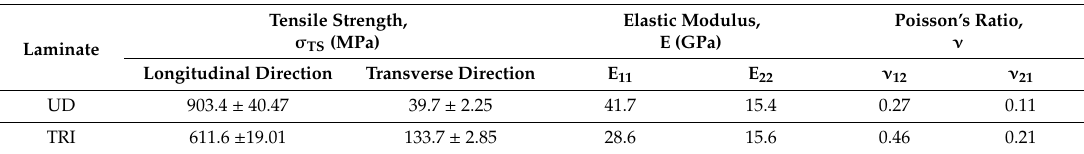
Table 1. Tensile properties of the unidirectional (UD) and tri-axial (TRI) Glass Fiber-Reinforced Plastic (GFRP) composite laminates.